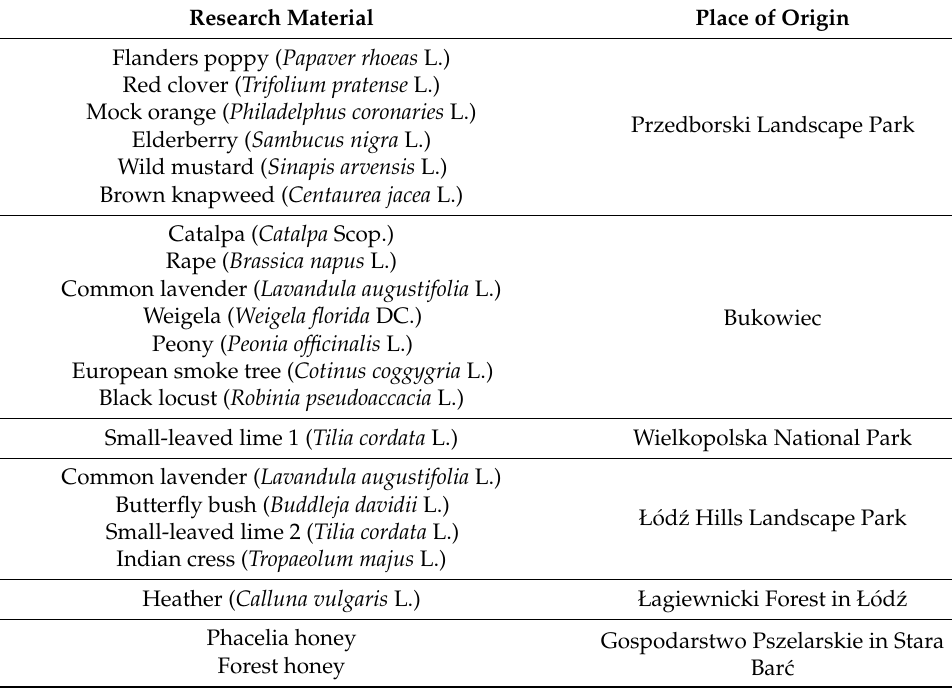
Table 1. Place of origin of the research material. Research